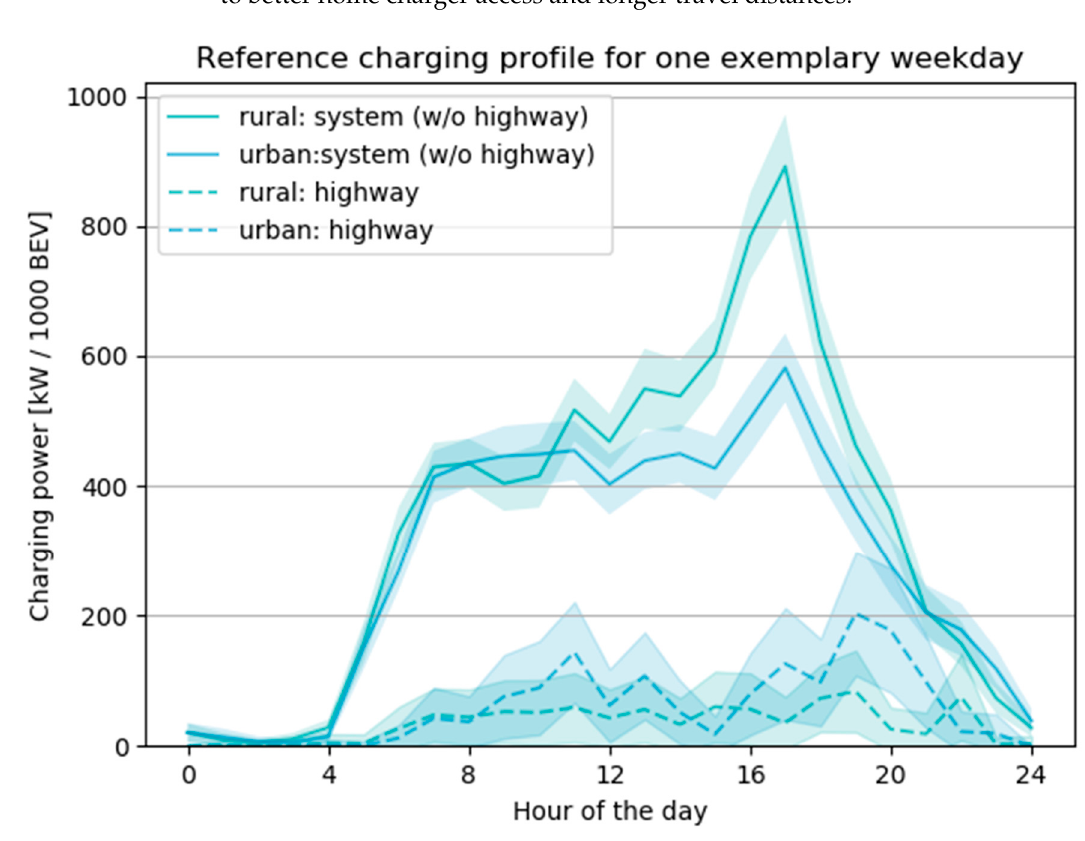
Figure 4. Reference scenario Charging Demand for one exemplary weekday within a rural and an urban region. The lines show the average over all 100 simulations of the reference case and the shadowed areas show the standard deviation for each hour of the day.